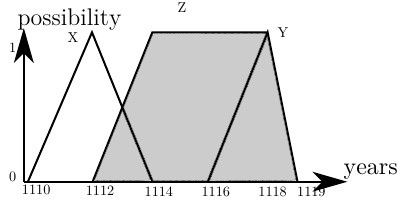
Fig. 2. Ill-known values X and Y . The grey area represents the ill-known value Z defined by the convex combination of the two ill-known constraints C 1 and C 2